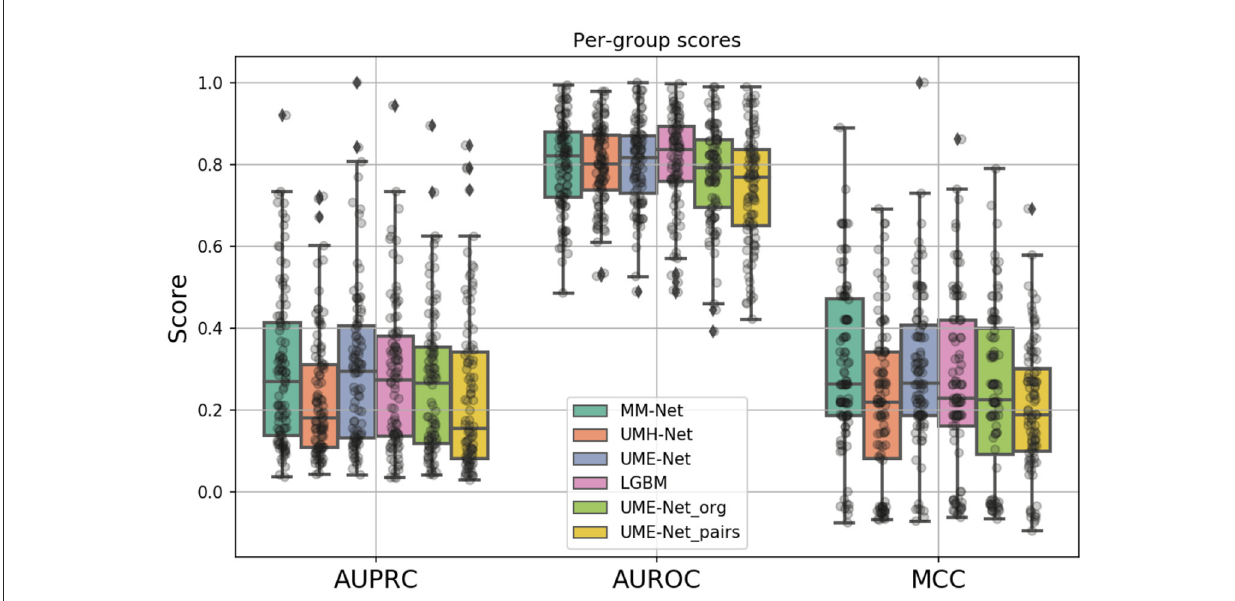
FIGURE6 Boxplots showing the distribution of scores for the investigated drug response prediction models. The differences between the models are summarized in Table 2.